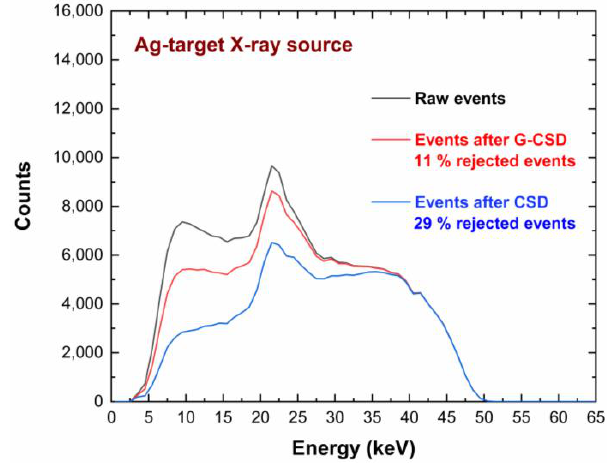
Figure 10. Charge sharing measurements of a tested pixel under Ag-target X-ray tube source. The red and blue lines represent the uncollimated energy spectra after G-CSD and CSD, respectively. The raw spectrum (black line) is also shown.